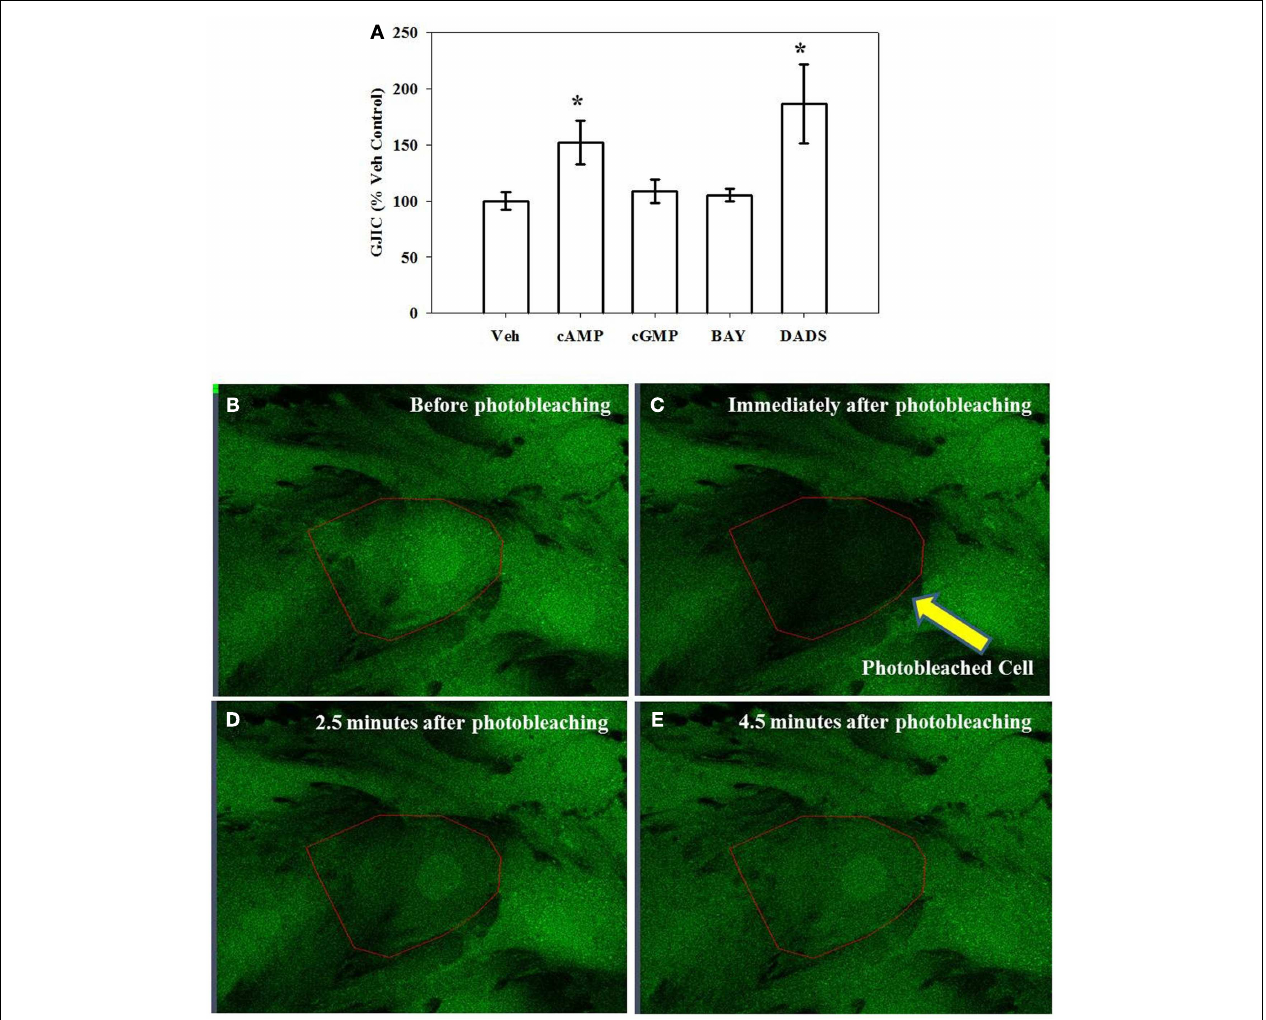
one-way ANOVA was used. * p < 0.05 compared with normalized vehicle controls. (B–E) Representative photomicrographs (630 × ) of confluent VSMCs undergoing FRAP with the targeted cell outlined. (B) Before photobleaching; (C) immediately after photobleaching; (D) 2.5min after photobleaching; and (E) 4.5min after photobleaching at the conclusion of fluorescence